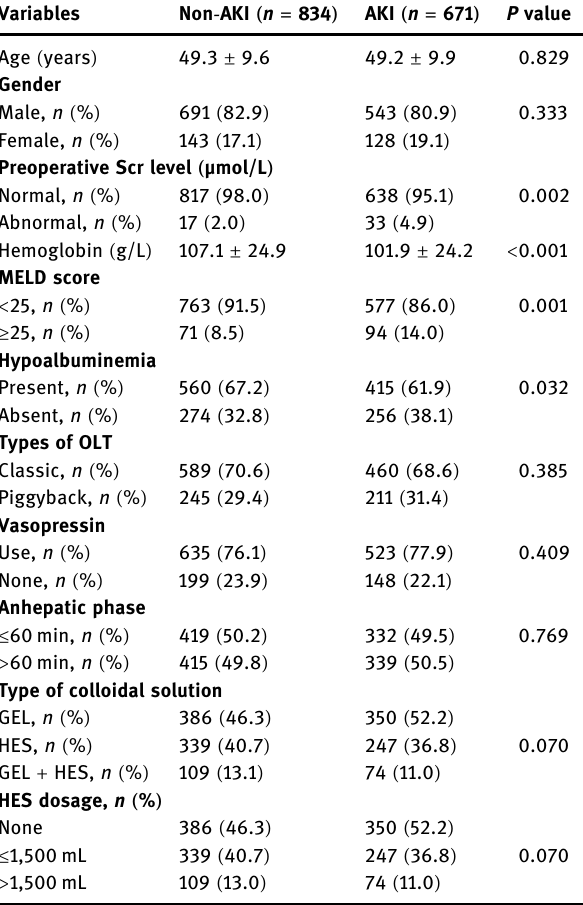
Table 3: Univariate analysis for risk factors of post - OLT AKI Variables